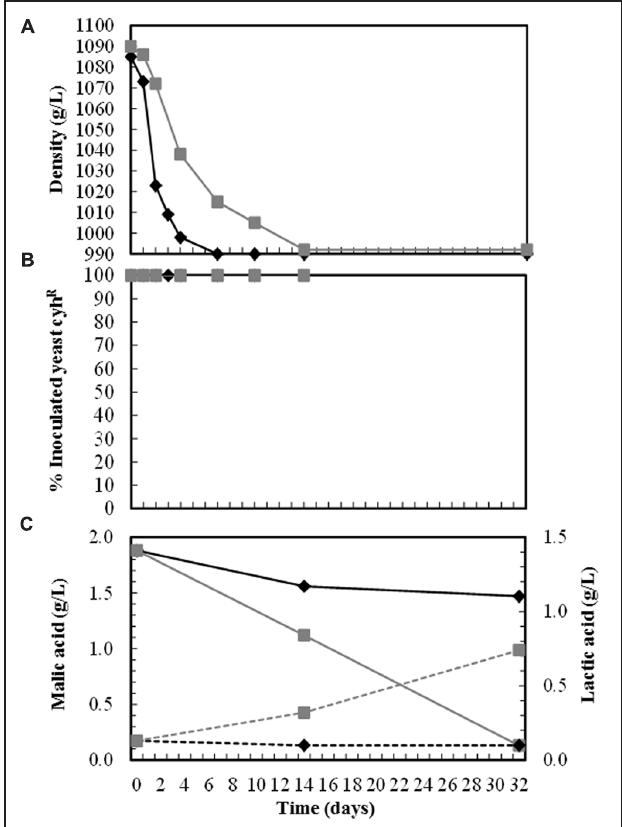
FIGURE 3 | Must fermentation kinetics (A), yeast population dynamics (B), and malic/lactic acid degradation/productionduring the vinification trials done with turbid cold-settled Macabeo grape musts (around 250 NTU, pH 3.55). Each yeast was single inoculated in the fresh must at a cell concentration of 2–4 × 10 6 CFU/mL for the S. cerevisiae strain E7AR1 (K2, cyh R ), and 2–4 × 10 7 CFU/mL for T. delbrueckii strain